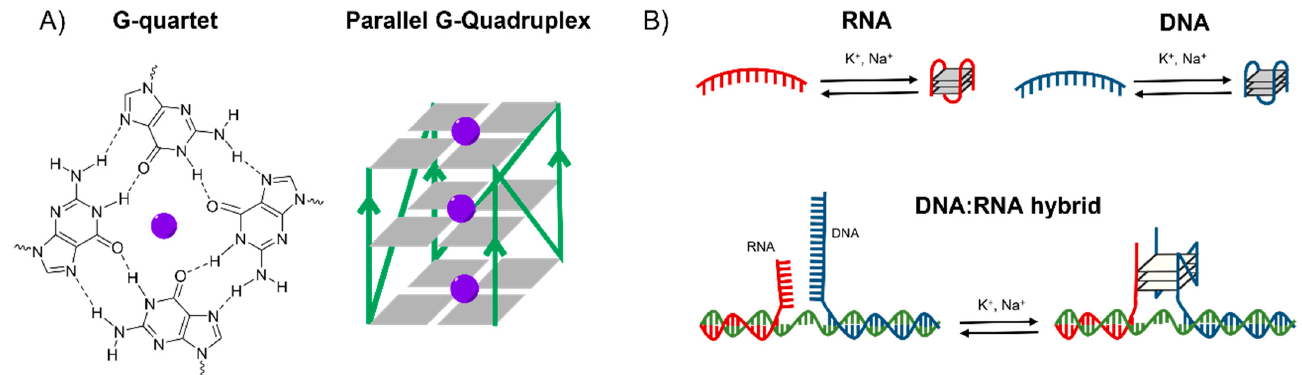
Figure 1. ( A ) Chemical structure of a G-quartet and schematic representation of a parallel G-quadruplex (G4). ( B ) Schematic representation of the three distinct G4s that can be formed within mitochondrial CSB II: unimolecular RNA G4 assembly adopted within the RNA transcript, unimolecular DNA G4 formed within the non-template strand and bimolecular DNA:RNA G4 hybrid formed between the non-template DNA and the RNA transcript.